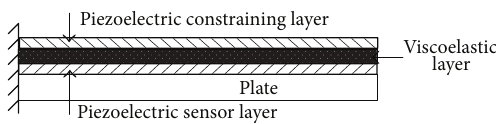
Figure 1: Schematic drawing of the ACLD/plate